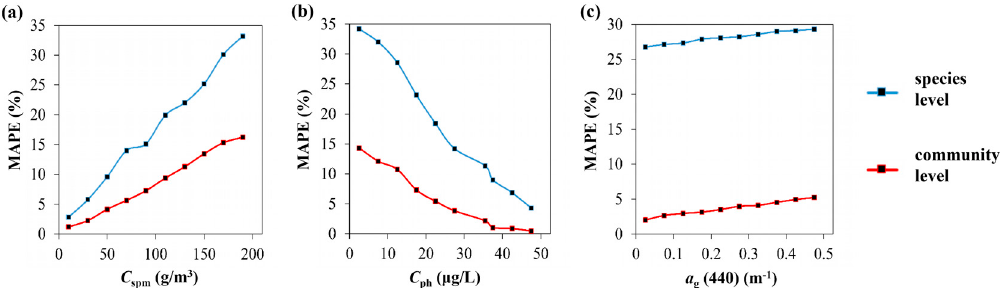
Figure 12. MAPE (%) of transfer learning-based DNN-predicted results of phytoplankton composition at the species level (blue line) and at the community level (red line) under various conditions of SPM concentration ( a ), chlorophyll a concentration ( b ) and CDOM absorption coefficient at 440 nm ( c ).